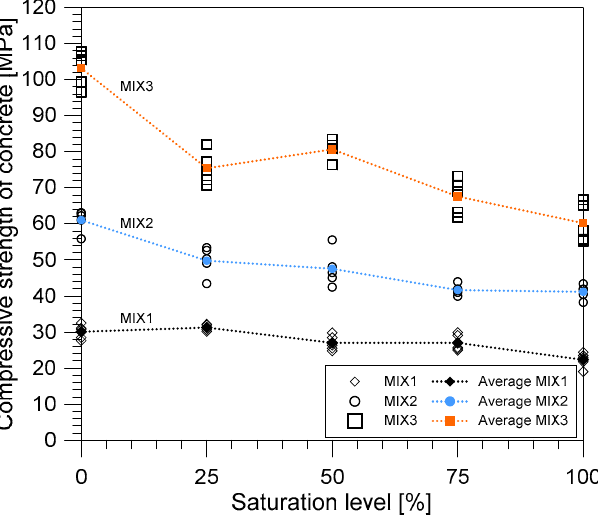
Figure 15. The variation of compressive strength of the different mix proportion with the degree of saturation.